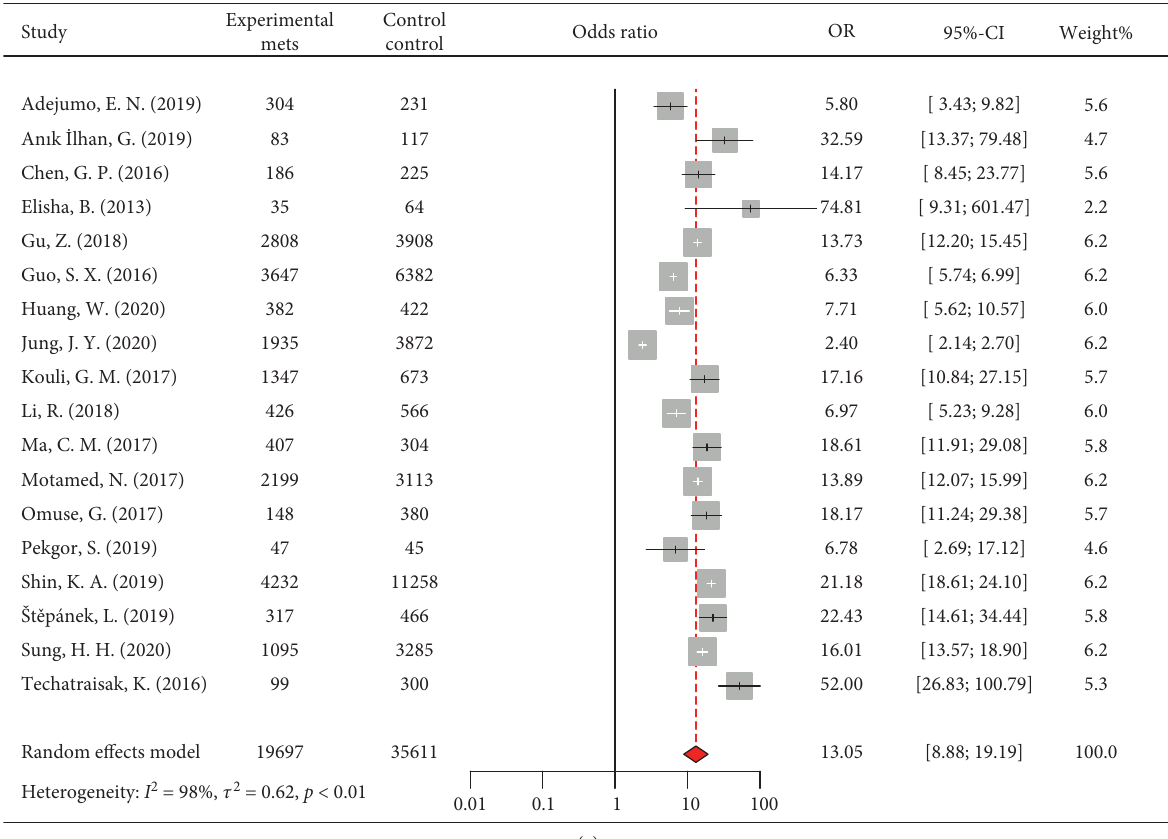
Figure 3: Forest plots of pooled (a) sensitivity, (b) specificity, and (c) diagnostic odds ratio of visceral adiposity index as a screening marker of metabolic